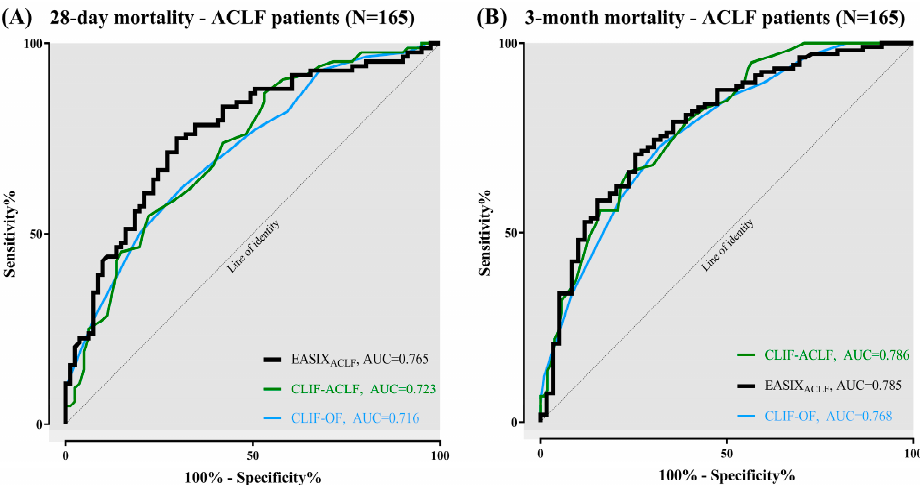
Figure 2. Prognostic ability of EASIX in ACLF-patients (N = 165) versus CLIF-OF and CLIF-ACLF to predict mortality: ( A ) 28-day mortality; and ( B ) 3-month mortality.